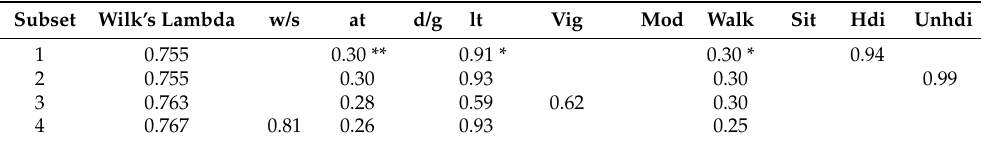
Table 2. Wilk’s Lambda and tolerances for the effects derived from the discriminant analysis are pre- sented for the best four subsets. The first subset contains the optimal set of variables for differentiating the four groups of